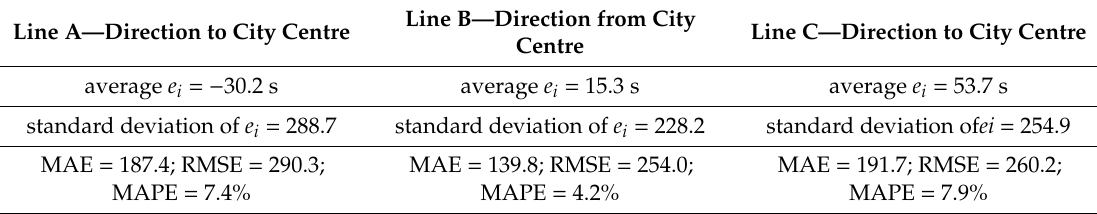
Figure 7. Example of a comparison between observed and forecasted/modelled values. Table 3. Accuracy indicators of a route of Lines A, B and